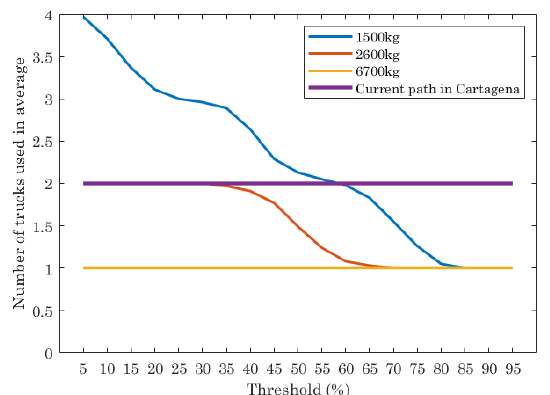
Figure 5. Number of trucks used, in average, for the optimal paths given by ILP and the current path in Cartagena.